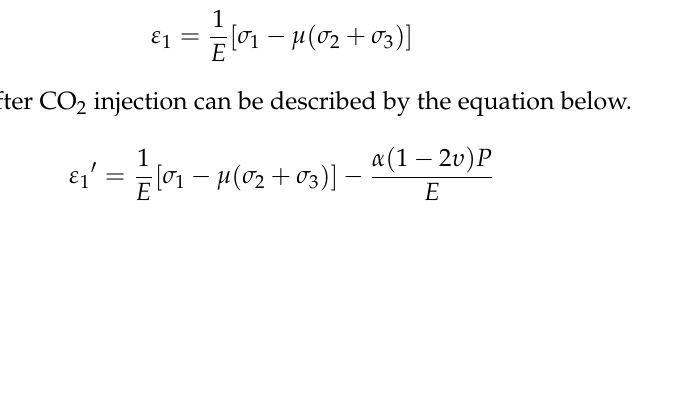
Figure 10. The adsorption-induced strain versus the pore pressure at 50 °C.